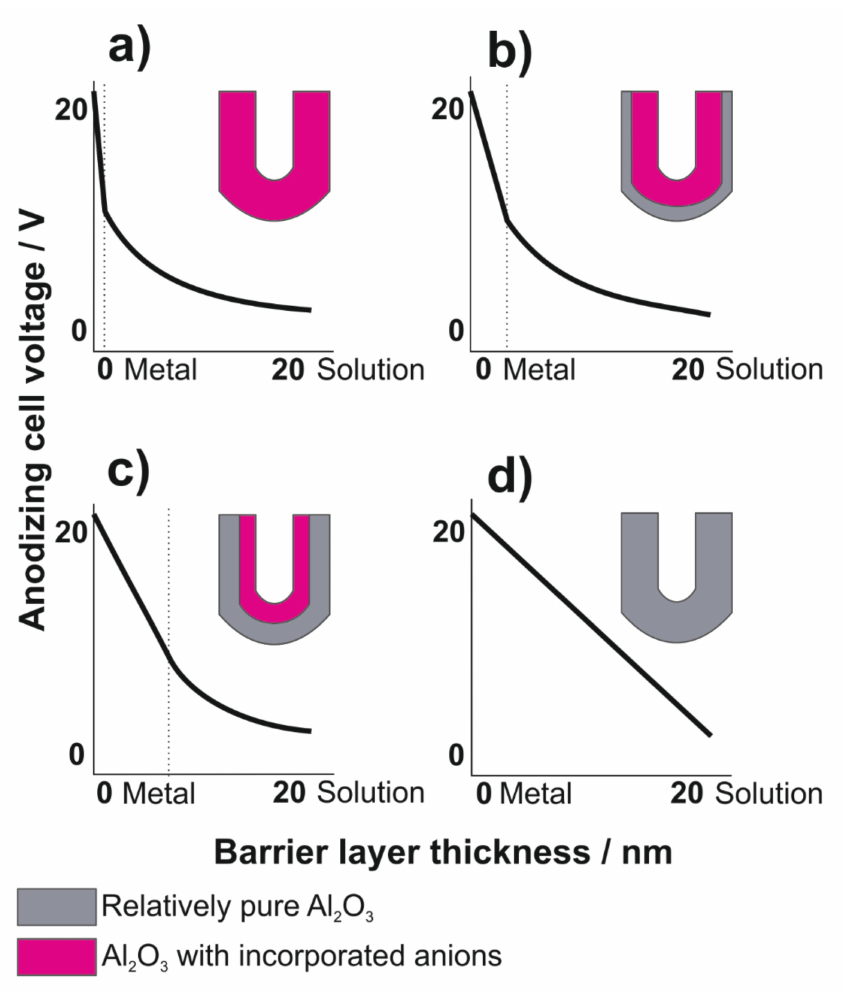
Figure 5. Distribution of the potential drop and electric field, E (slope of the voltage − distance plot), across barrier layers of porous AAOs formed in ( a ) sulfuric, ( b ) oxalic, ( c ) phosphoric, and ( d ) chromic acid. Reproduced with permission from Ref. [1]. Copyright 2014 American Chemical